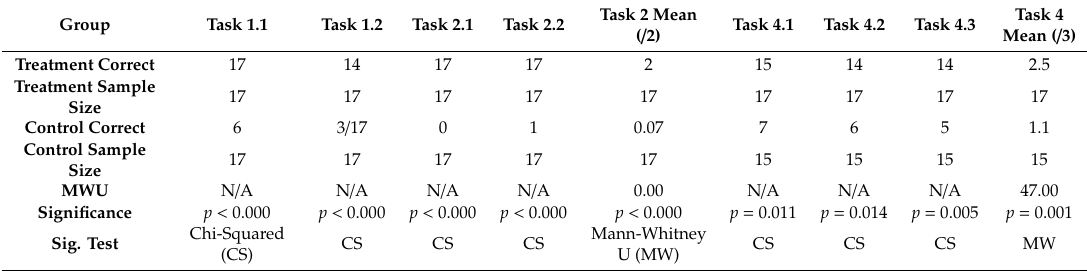
Table 2. Online presence